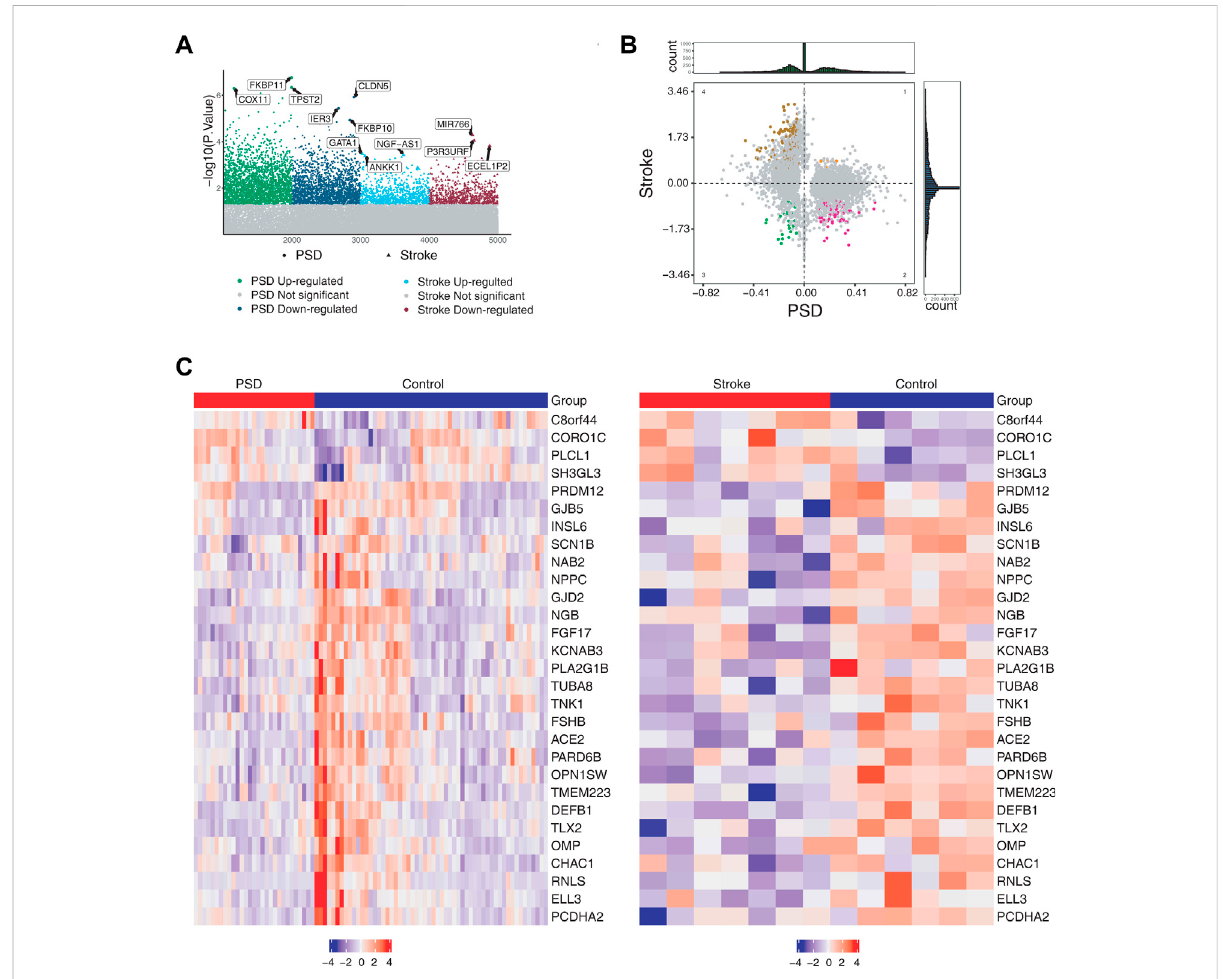
Molecular characteristics of stroke and PSD patients. (A) . Manhattan diagram depicting dysregulated genes in stroke and PSD patients. (B) . Quadrant chart presenting the expression pattern of genes in stroke and PSD patients. (C) . Heatmap indicating consistent upregulation of gene expression in stroke and PSD patients. (D) . Heatmap indicating genes that are dysregulated in opposite directions in stroke and PSD patients. (E) . Heatmap revealing the expression of depression-speci fi c genes in PSD patients and stroke. (F) . Paired scatterplot depicting the expression of genes in stroke and PSD